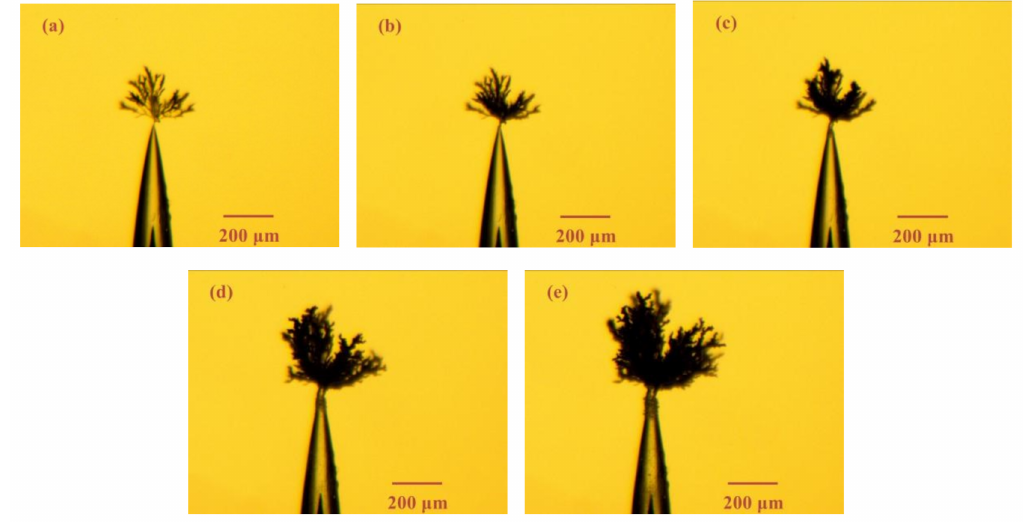
Figure 7. Electrical tree morphology in epoxy casting insulation sample with big air gap under 1 kHz / 8 kV bipolar square-wave voltage at time of ( a ) 5 min, ( b ) 20 min, ( c ) 40 min, ( d ) 120 min, ( e ) 240 min.